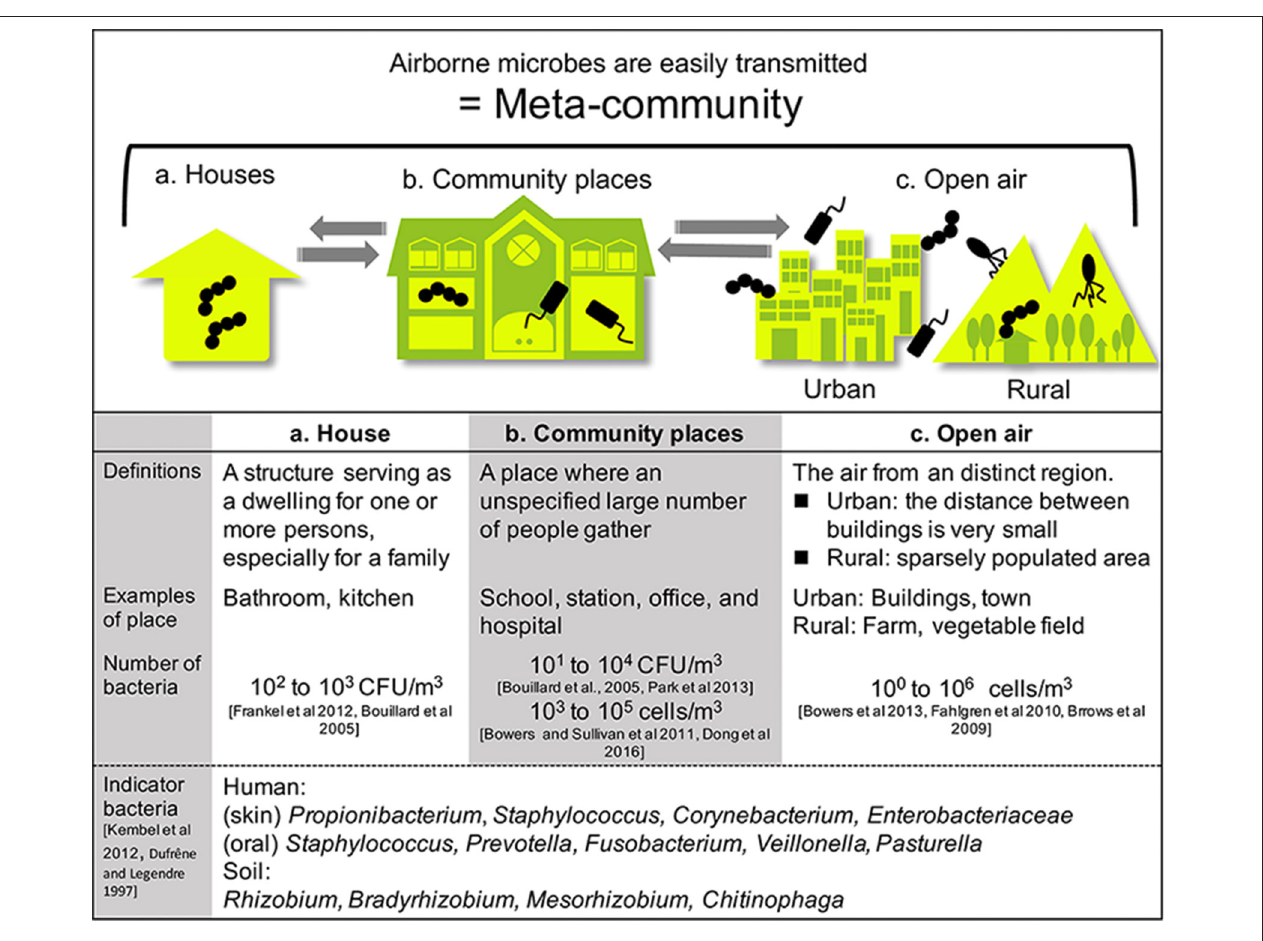
FIGURE 2 | Built environments were classified into two areas: houses and community spaces. People living and working in such spaces constantly interact with microbes. Airborne microbes also occupy a wide range of built environments. Each type of space is connected by air, including open-air